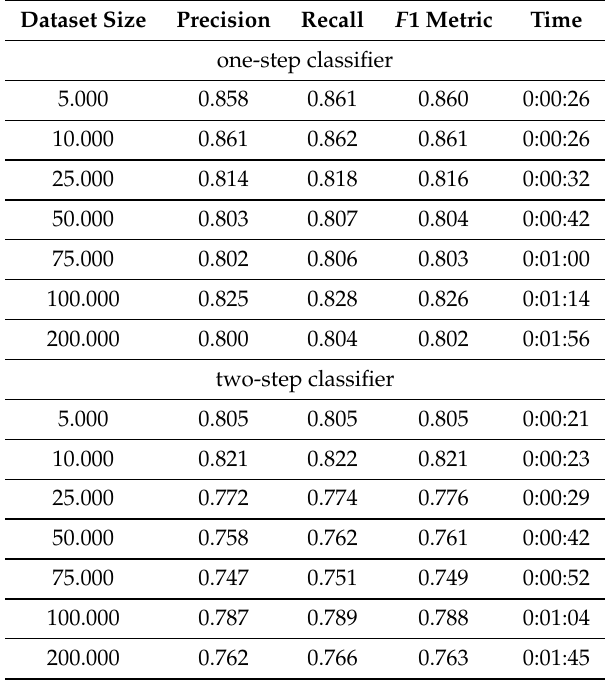
Table 13. Logistic